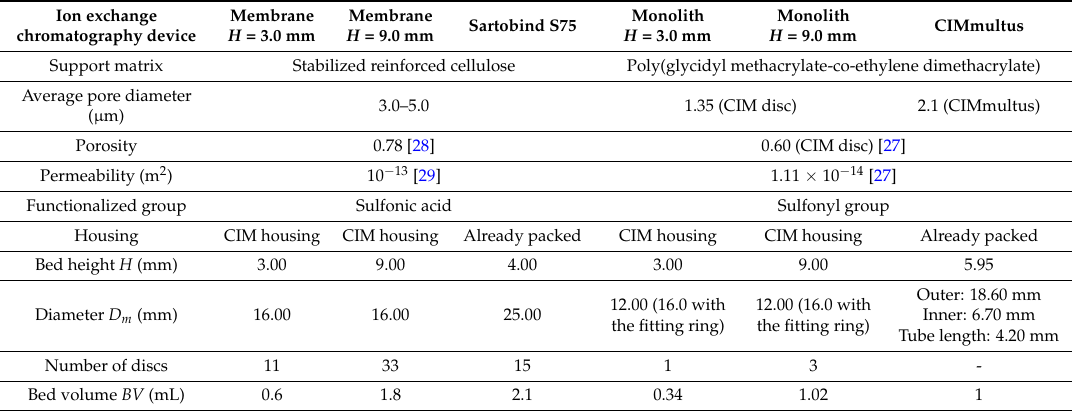
Table 1. Characteristics of the different devices of strong cation exchange